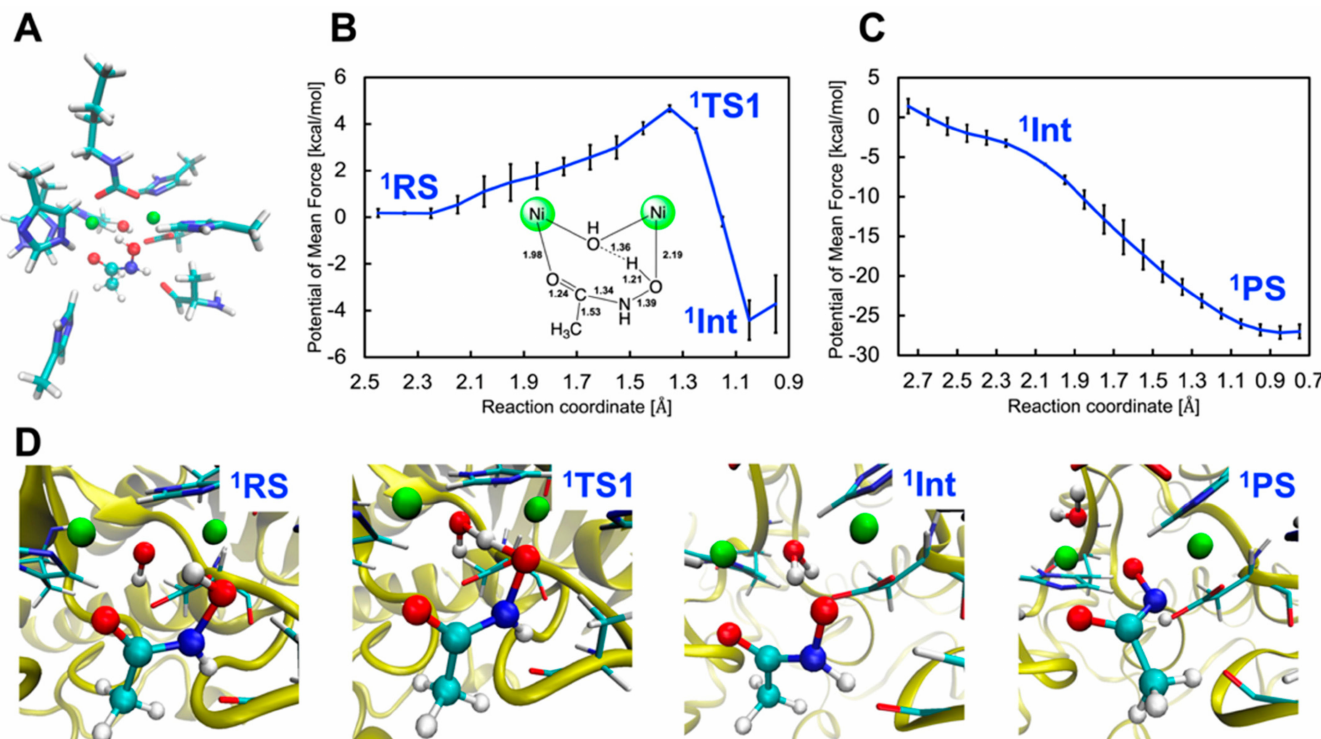
Figure 1. ( A ) QM region of the AHA-bound complex ( 1 RS ) obtained with the QM/MM MD equili- bration; ( B ) one-dimensional potentials of mean force (1D-PMFs) for the proton transfer from AHA to WB, with an illustration of 1 TS (key distances are provided in Å); ( C ) 1D-PMFs for AHA-inhibited complex formation; and ( D ) representative snapshots of the active sites in 1 RS , 1 TS , 1 Int , and 1 PS